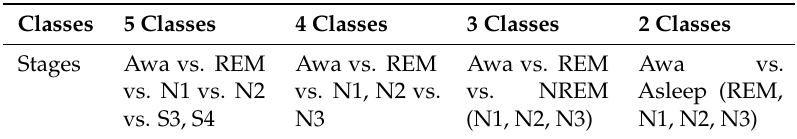
Table 2. The class description considered in this work under the American Academy of Sleep Medicine (AASM)